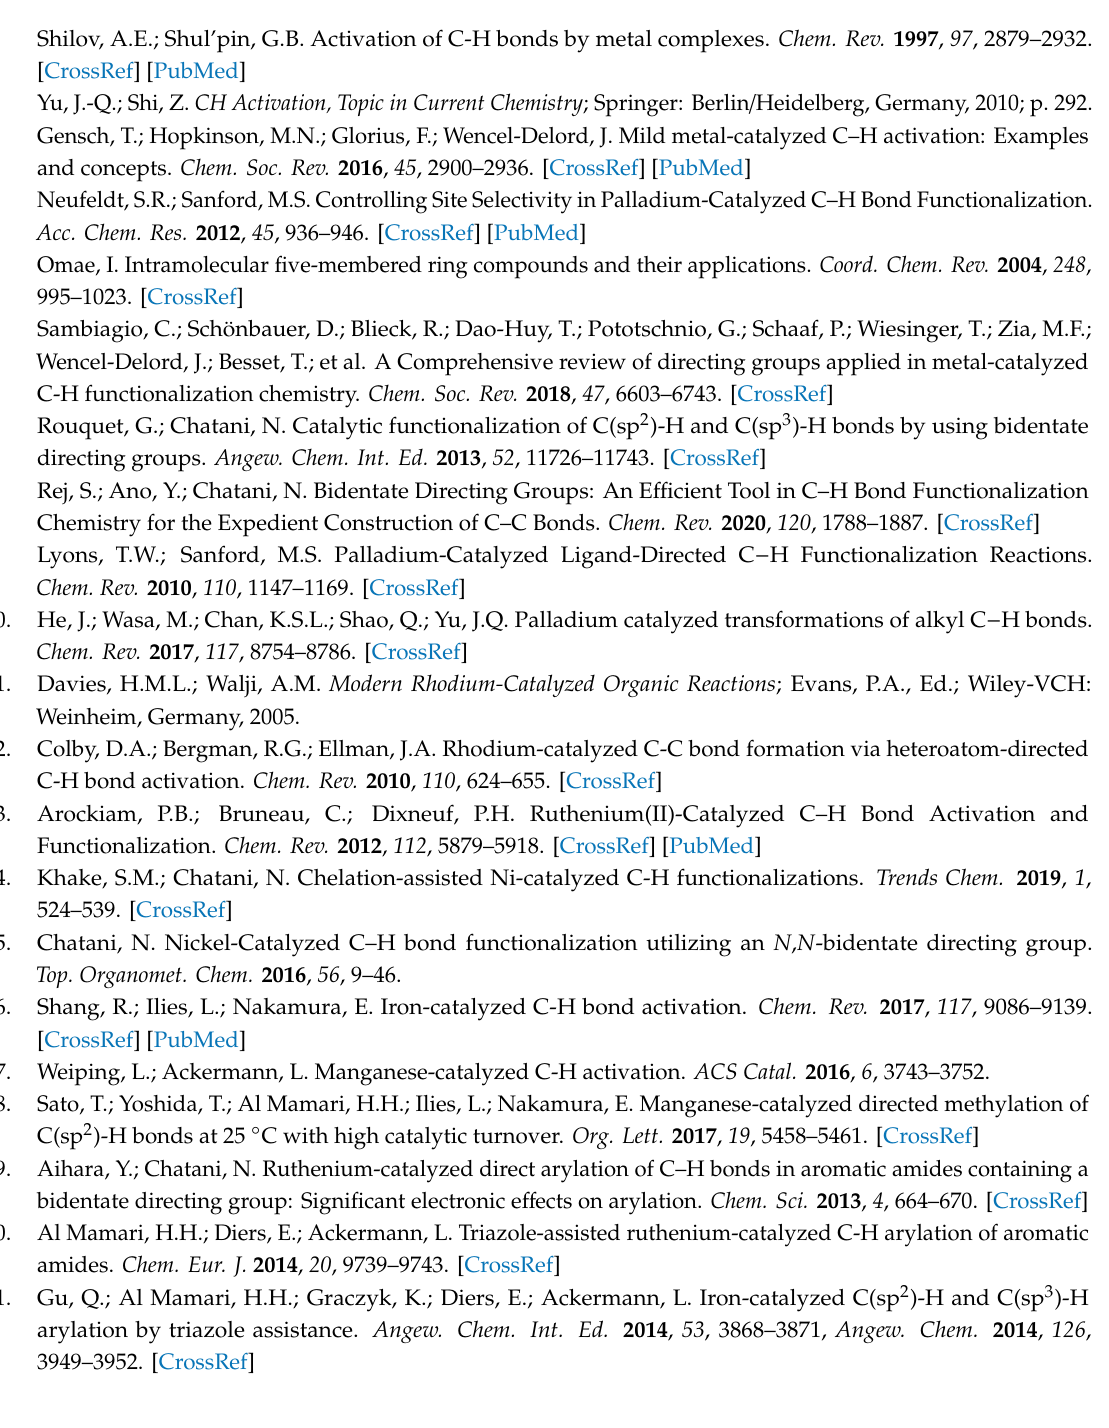
Supplementary Materials: The following are available online, Figure S1: 1 H NMR of the title compound, Figure S2: 13 C NMR of the title compound, Figure S3: IR of the title compound, Figure S4: GC-MS of the title